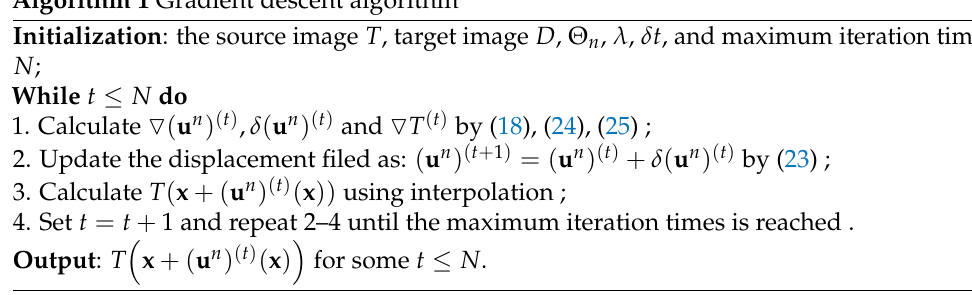
Algorithm 1 Gradient descent algorithm